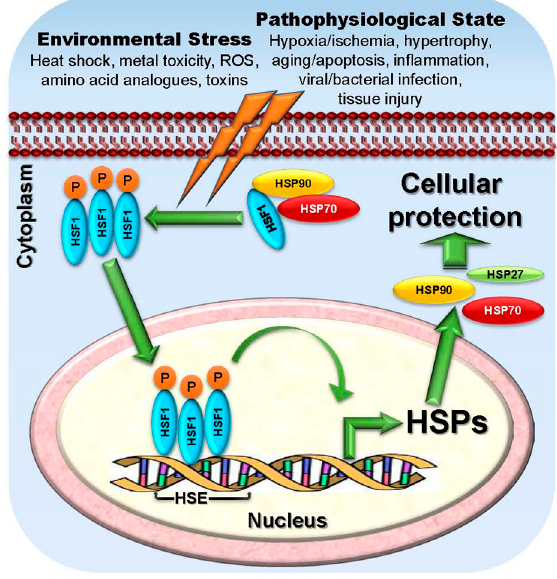
Figure 1. Role of heat shock transcription factor 1 (HSF1) in modulating HSP expression. Under unstressed condition, HSF-1 is sequestered in the cytoplasm by HSPs (HSP90, HSP70) which bind to HSF1 blocking its transcriptional activity. In response to stress (orange lightning bolts), whether environmental such as high temperatures, metal toxicity, reactive oxygen species (ROS), amino acid analogues, and toxins or pathophysiological such as hypoxia or ischemia, hypertrophy, aging, apoptosis, inflammation, viral or bacterial infection, and other tissue injury, HSPs dissociate from the complex activating HSF1. Following nuclear translocation, HSF1 binds to specific heat shock elements (HSE) sequences that are present upstream of heat shock gene promoters to activate transcription of HSP genes in order to promote cellular protection for the survival.